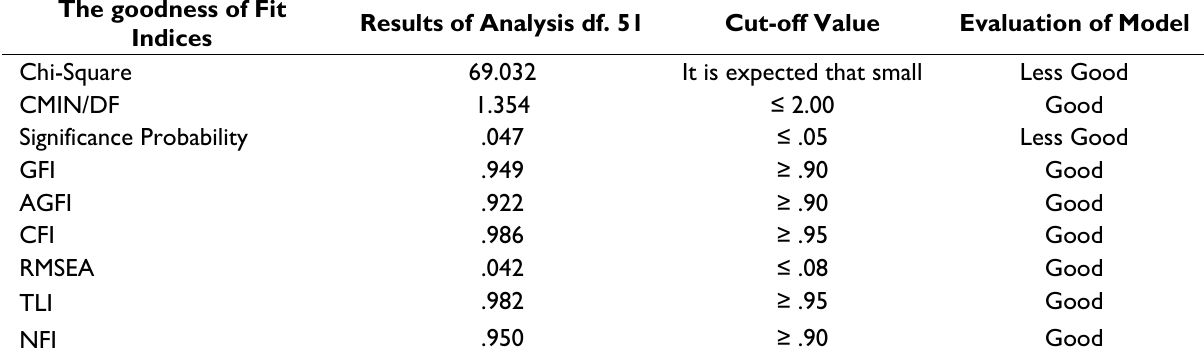
Table 2. The goodness of Fit Indices on